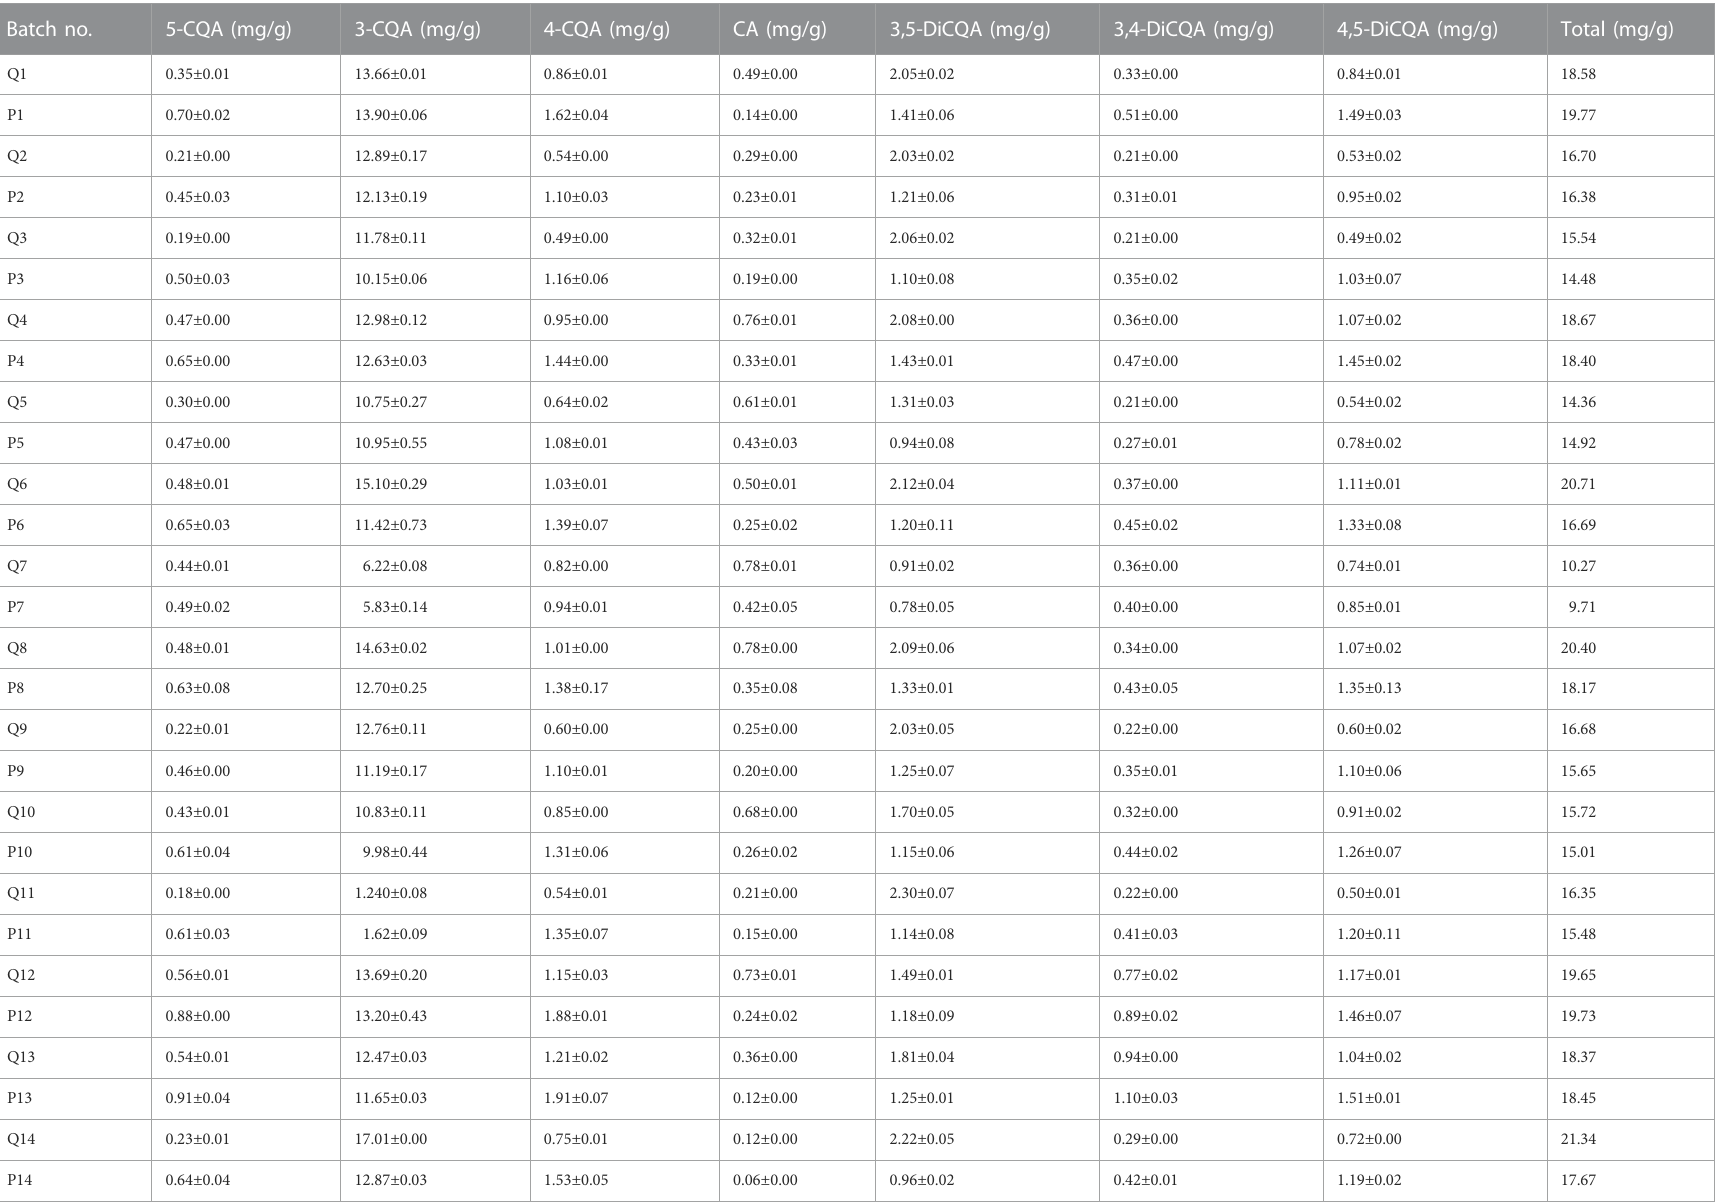
TABLE 2 Contents of the 7 phenolic acids in 14 batches of RPS and SPS samples. Batch